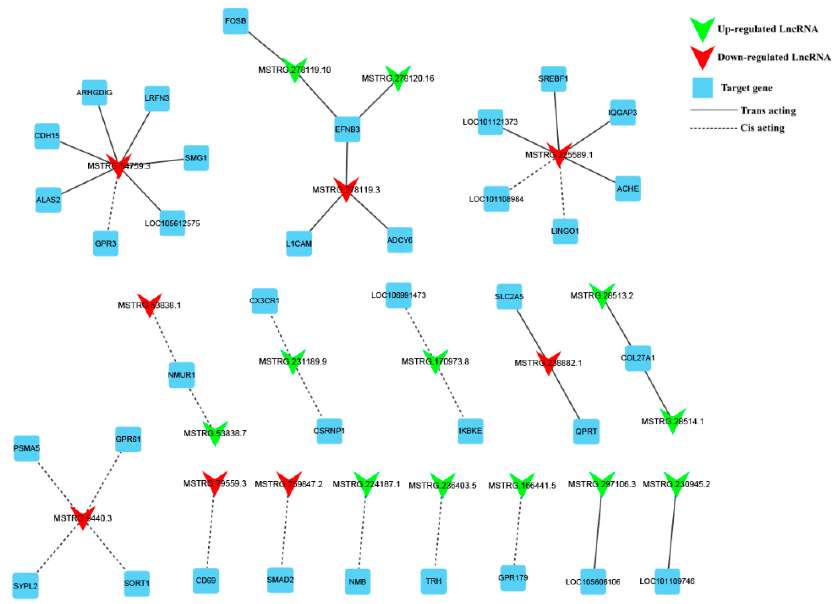
Figure 6. 20 DE lncRNAs and their predictably interactive 36 cis- and trans-targeted genes were composed of this interactive network. The red and green color represent up- and down-regulation, quadrilaterals represent lncRNA, the box represents targeted genes, the straight line and dotted line represent the interaction relationship with trans-and cis-regulation, respectively. CDH15 , Cadherin-15; ARHGDIG , Rho GDP dissociation inhibitor γ ; LRFN3 , leucine rich repeat and fibronectin type III domain containing 3; SMG1 , suppressor of morphogenesis in genitalia 1; ALAS2 , 5 ′ -aminolevulinate synthase 2; GPR3 , G protein-coupled receptor 3; FOSB , FosB proto-oncogene, AP-1 transcription factor subunit; EFNB3 , ephrin B3; L1CAM , L1 cell adhesion molecule; ADCY6 , adenylate cyclase 6; SREBF1, sterol regulatory element binding transcription factor 1; IQGAP3 , IQ motif containing GTPase activating protein 3; ACHE , acetylcholinesterase; LINGO1 , leucine rich repeat and Ig domain containing 1; NMUR1 , neuromedin U receptor 1; CXCR1 , C-X-C motif chemokine receptor 1; CSRNP1 , cysteine and serine rich nuclear protein 1; IKBKE, inhibitor of nuclear factor kappa B kinase subunit epsilon; SLC2A5 , solute carrier family 2 member 5; QPRT , quinolinate phosphoribosyl transferase; PSMA5 , proteasome subunit α 5; GPR61 , G protein-coupled receptor 61; SYPL2, synaptophysin like 2; SORT1 , sortilin 1; CD69 , CD69 molecule; SMAD2 , SMAD family member 2; NMB , neuromedin B; TRH , thyrotropin releasing hormone; GPR179 , G protein-coupled receptor 179.